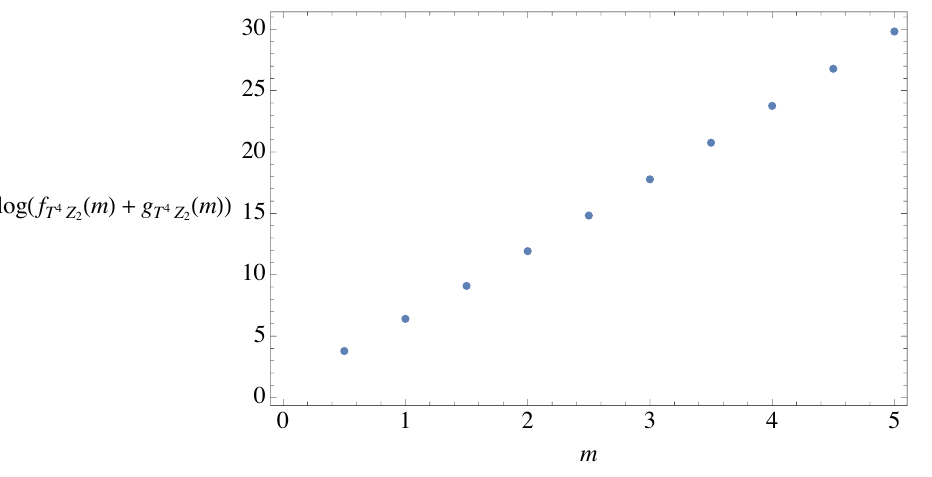
( m ) + g ( m )) up to m = 5 for T 4 = Z 2 . Note the exponential T 4 = Z 2 T 4 = Z 2